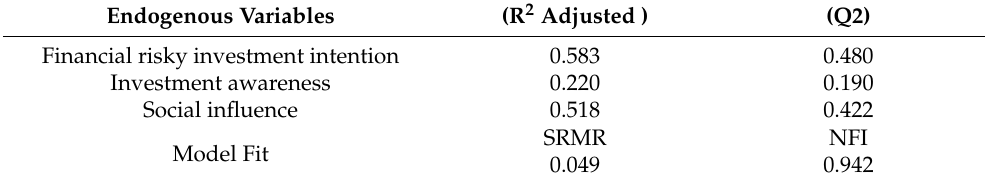
Table 4. Model GoF